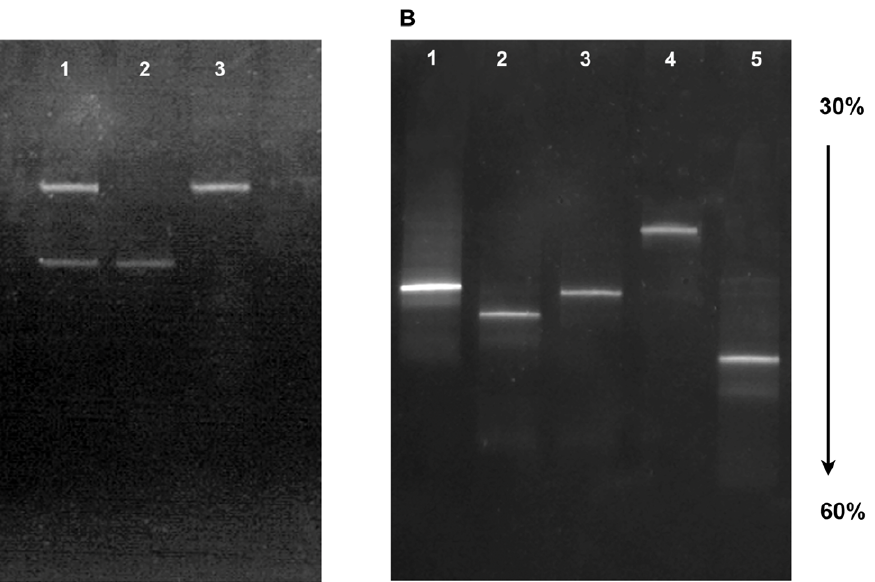
Figure 6. Fine resolution of ISA segment 5 and 6 of ISA variants via parallel DGGE. Panel A. Lane 1 mix of the segment 5 with and without insert, Line 2 segment 5 without insert (GU830907), Line 3 segment 5 with insert (EU130923); Panel B: Lines 1–5, HPR marker variants: HPR0, HPR2, HPR5, HPR7b and HPR8, correspondingly (for the accesion number see Table 1).